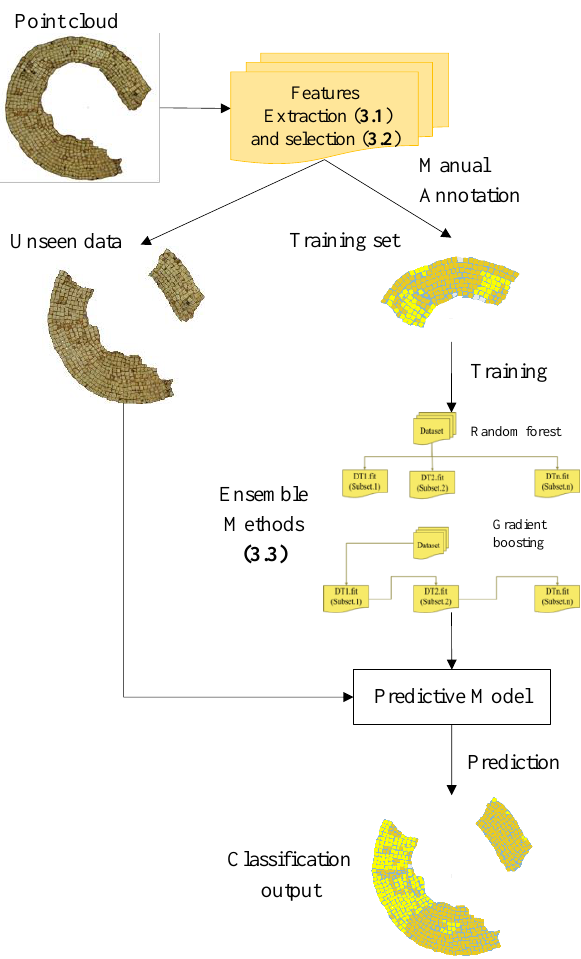
Figure 2. Global workflow for point clouds semantic segmentation using Ensemble